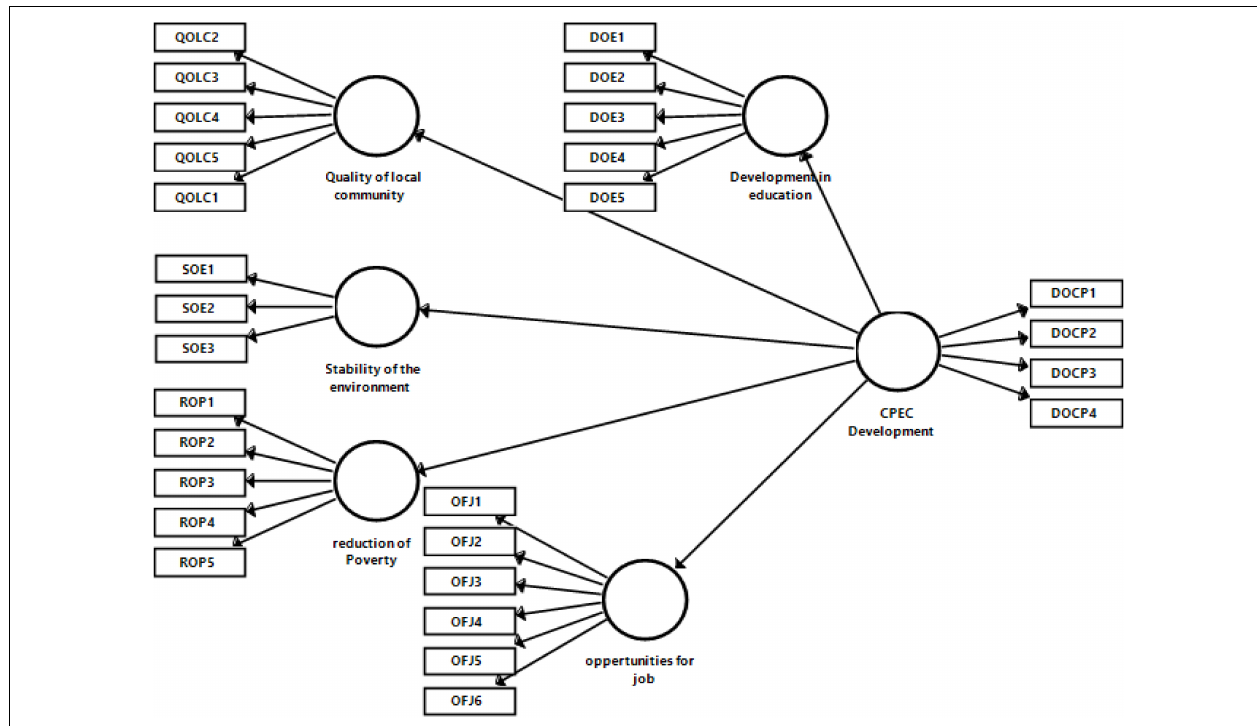
FIGURE 1 | Proposed